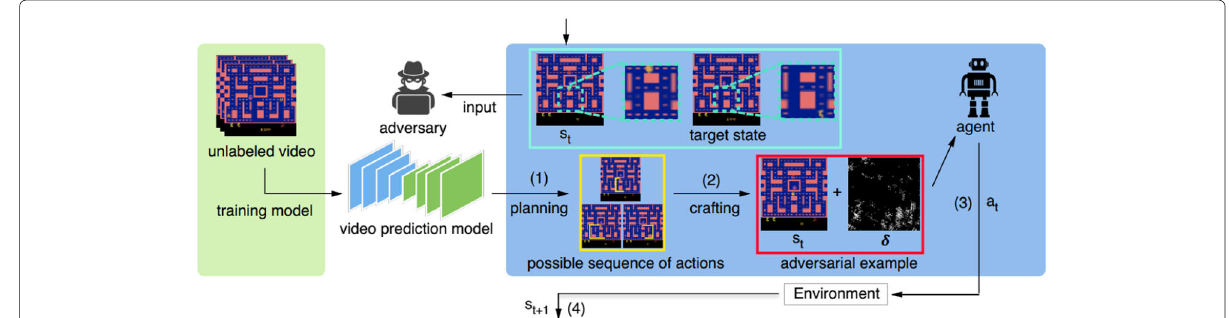
Fig. 7 Attacking flow for enchantingattack (Lin et al. 2017). Enchanting attack from the original state s t , the whole processing flow can be concluded as follow: 1) action sequence planning; 2) generating adversarial examples with target actions; 3) agent takes actions under adversarial example; 4) environment gives the next sate s t + 1 . Meanwhile, adversary utilizes the prediction model to attack the target agent with initial state s